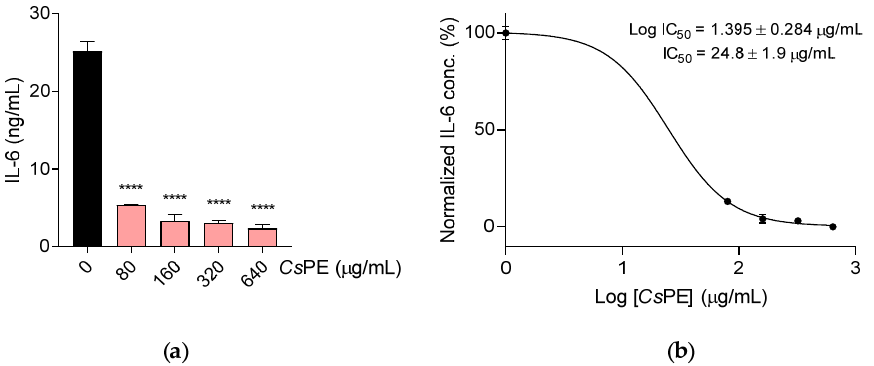
Figure 4. Inhibition of IL-6 secretion in proinflammatory cultures of LPS-activated RAW 264.7. RAW 264.7 cells were cultured with LPS alone (control, black bar) or in combination with different amounts of Cs PE for 24 h (pink bars). ( a ) IL-6 concentration in the culture supernatants was determined by the ELISA test. Results are reported as the mean ± SD of three independent experiments, each conducted in triplicate. **** p < 0.0001, LPS/ Cs PE-treated versus LPS-activated cells (one-way ANOVA test). ( b ) A concentration-response curve was obtained to determine the IC 50 of Cs PE. The IC 50 value was determined using non-linear regression analysis.